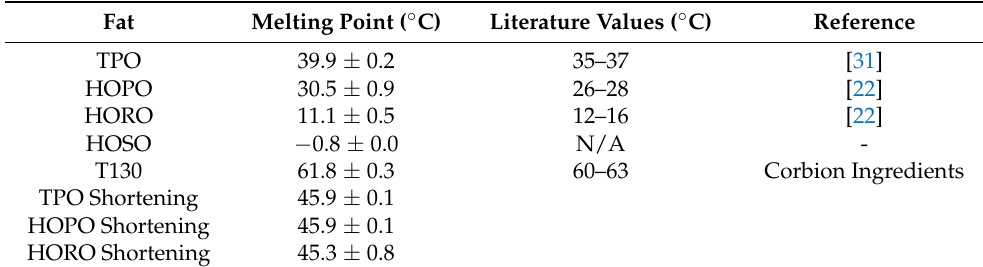
Table 8. Melting points ( ◦ C) of unblended oils, emulsifier and produced